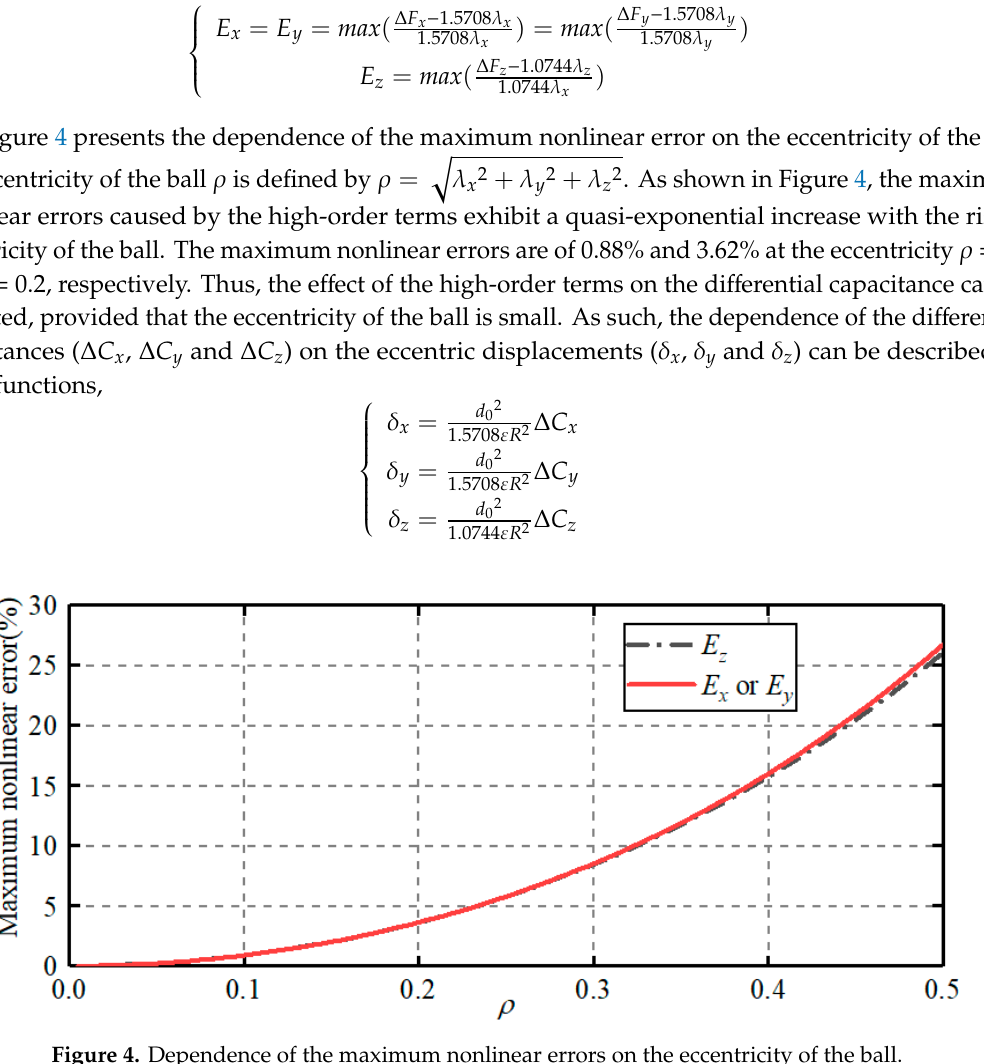
Figure 4. Dependence of the maximum nonlinear errors on the eccentricity of the ball.